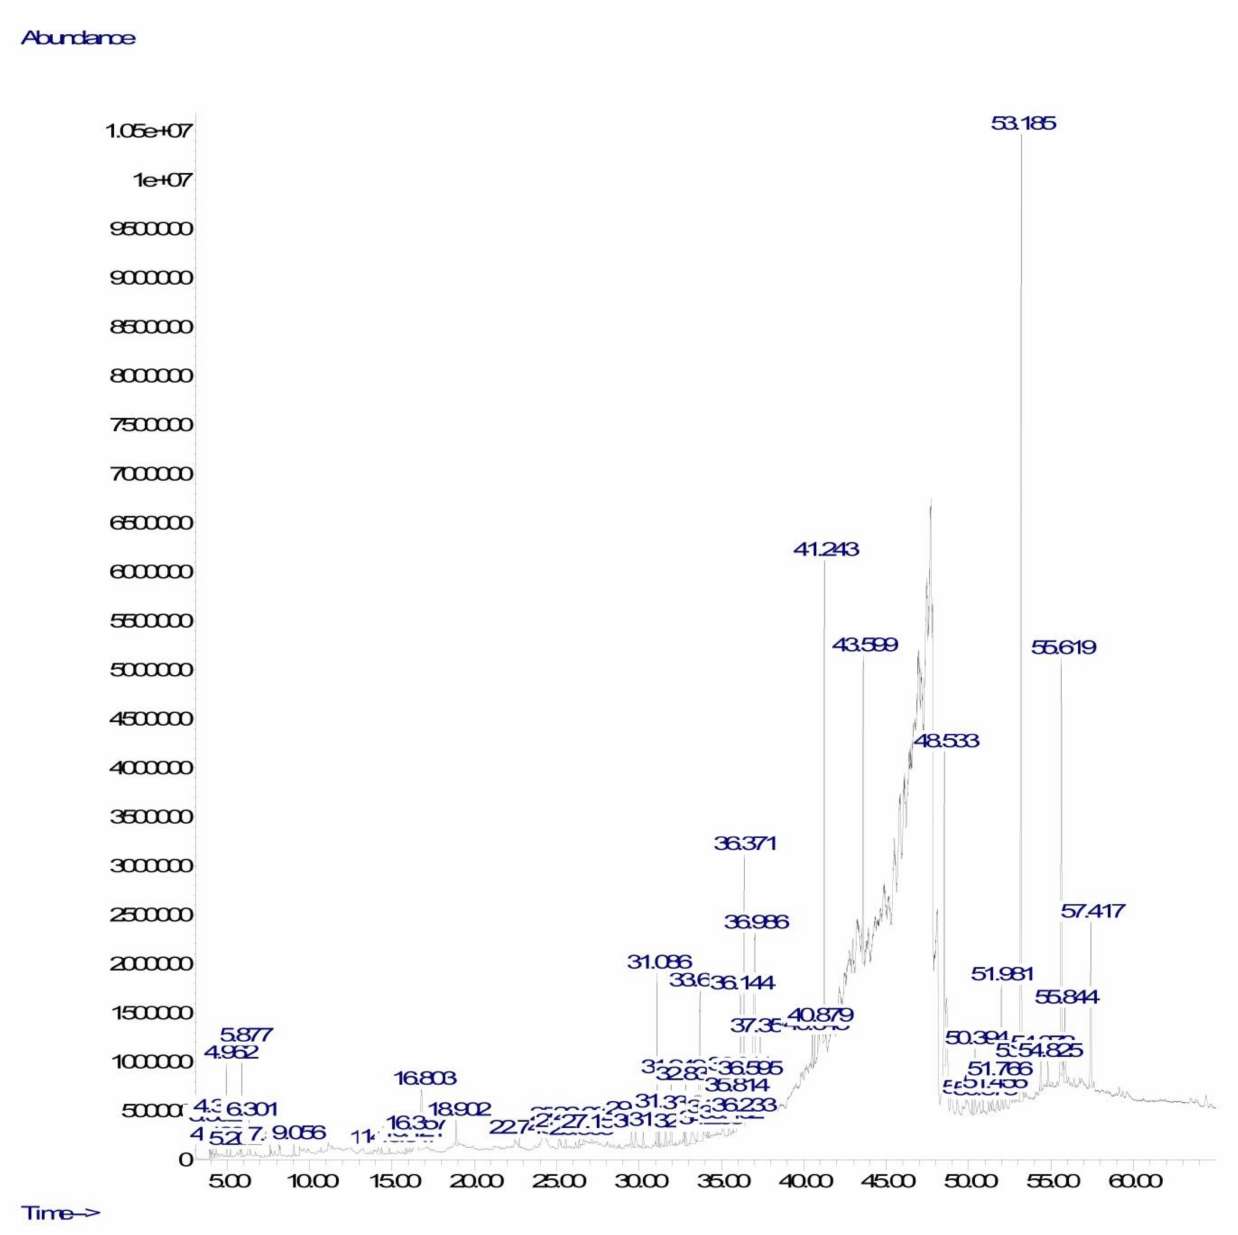
Figure 1. Total ionic chromatogram (TIC) of methanol extract of Cnesmone javanica (CV) using gas chromatography–mass spectrometry